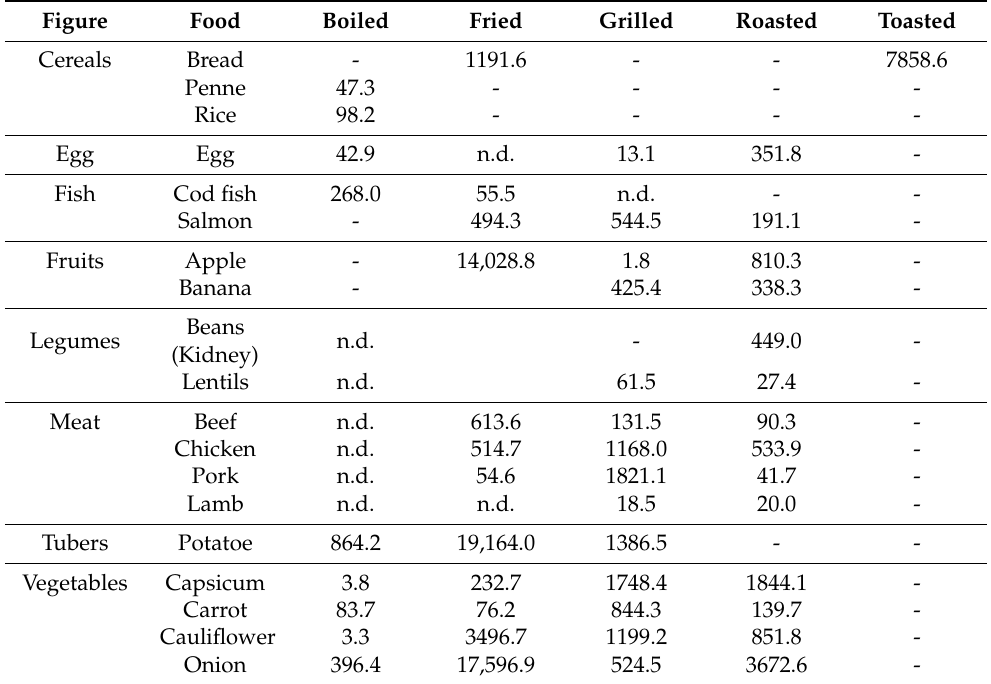
Table 3. Furfural values (expressed in µ g Furfural/g of food) depending on the cooking method applied to the food.